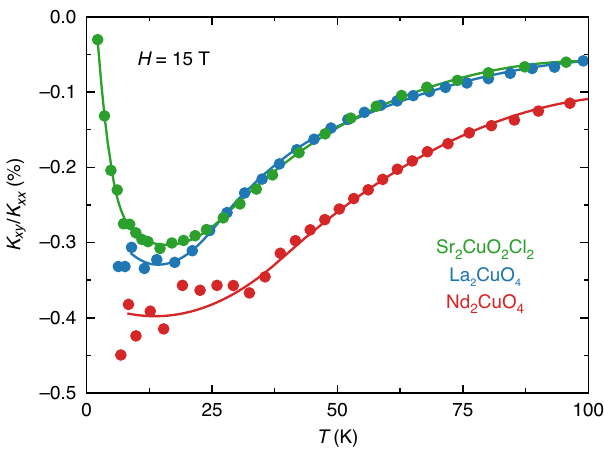
Fig. 4 Ratio of κ xy over κ xx . Ratio of κ xy over κ xx in the three cuprate Mott insulators (expressed in %), measured in a fi eld of 15 T applied parallel to the c- axis: Sr 2 CuO 2 Cl 2 (green), La 2 CuO 4 (blue), and Nd 2 CuO 4 (red). All lines are a guide to the eye. We see that despite a factor 10 in the magnitude of κ xy between Sr 2 CuO 2 Cl 2 and Nd 2 CuO 4 (Fig. 2), the ratio κ xy / κ xx is very similar in magnitude for all three cuprates.